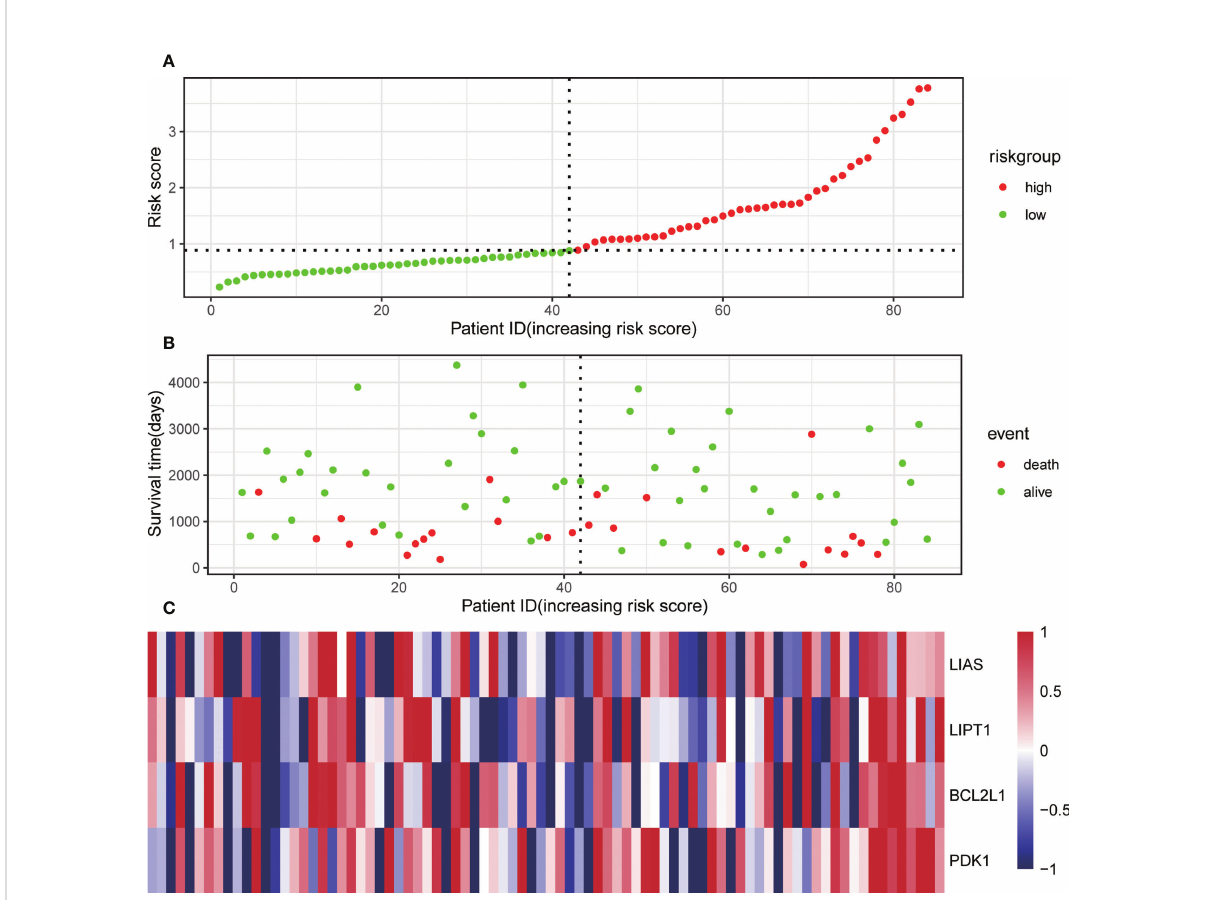
FIGURE 2 Associations of the risk score with the expression levels of four Cuproptosis-Related Genes included in the risk model. (A) Dot plot of risk score. (B) Dot plot of survival. (C) Heat map of the expression levels of the four